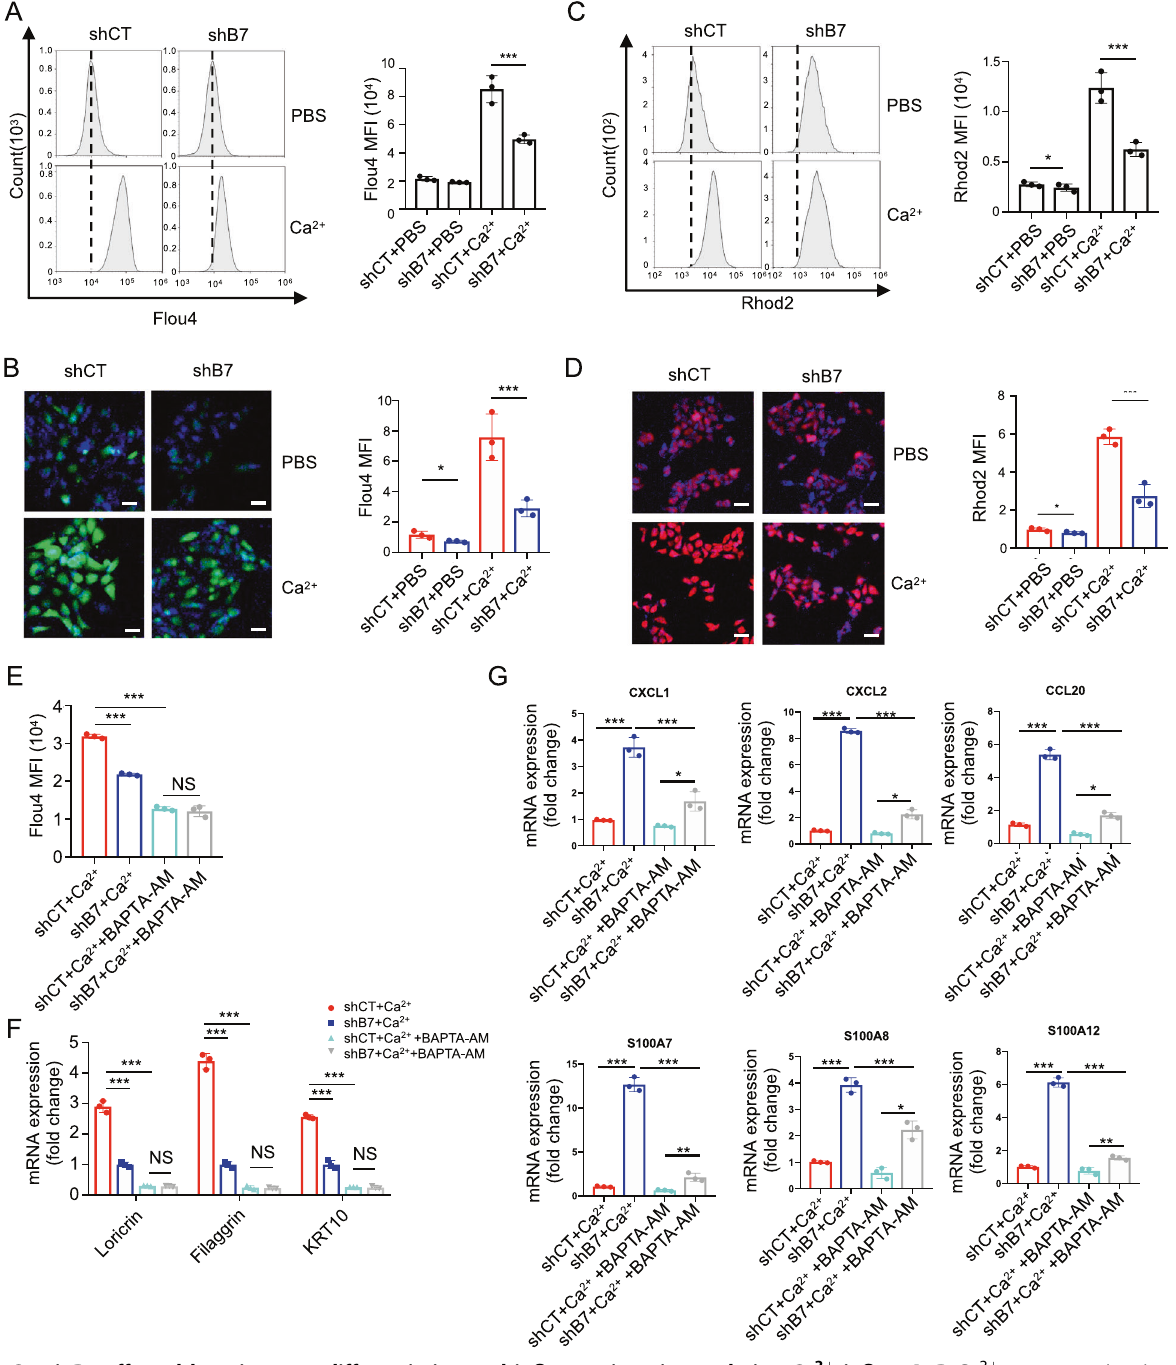
Fig. 6 SerpinB7 affected keratinocytes differentiation and in fl ammation via regulating Ca 2 + in fl ux. A , B Ca 2 + concentration in cytosol ([Ca 2 + ] c ) and C , D Ca 2 + concentration in mitochondria ([Ca 2 + ] m ) of shSerpinB7 and shCT NHEKs homeostasis and treated for 24 h with 1.6 mM Ca 2 + were measured by fl ow cytometry and fl uorescence confocal imaging using Flou4-AM and Rhod2-AM, respectively. E [Ca 2 + ] c of Ca 2 + - induced shSerpinB7 and shCT NHEKs treated with BAPTA-AM were measured by fl ow cytometry using Flou4-AM. F The mRNA level of keratinocyte differentiation markers in Ca2 + -induced shSerpinB7 and shCT NHEKs treated with BAPTA-AM was measured by RT-PCR. G The mRNA level of chemokines and microbial peptides in Ca 2 + -induced shSerpinB7 and shCT NHEKs treated with 20 um/mL BAPTA-AM was measured by RT-PCR. Flou4-AM: intracellular calcium indicator, Rhod2-AM mitochondrial Calcium indicator, BAPTA-AM, Mean ± SD. * P < 0.05; ** P < 0.01; *** P < 0.001. Two-tailed Student ’ s t -test ( A – D ), one-way ANOVA ( E – G ). All the data are representative of three independent